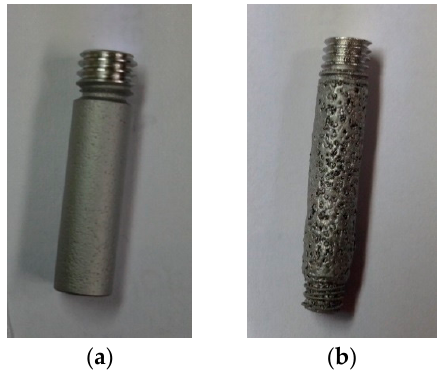
Figure 1. Samples (6 mm diameter) after in-situ measurement at HT (up to 1500 °C): ( a ) without boron, ( b ) 1000 ppm B sample.